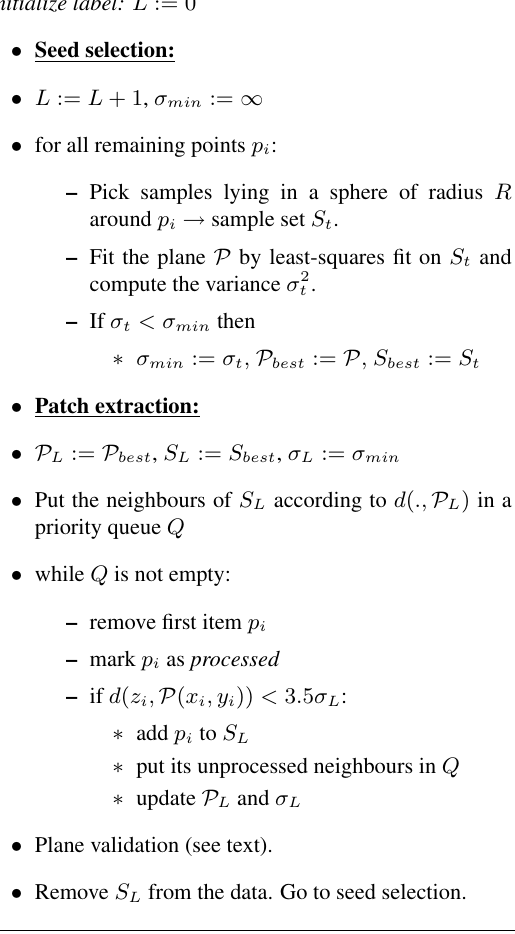
Figure 9: Our TomoSeed